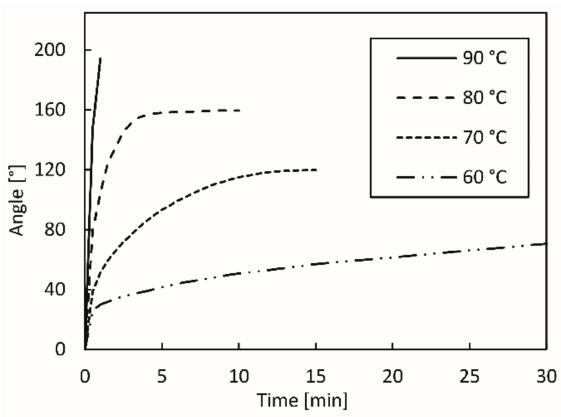
Figure 11. Transformation angle as a function of transformation time.